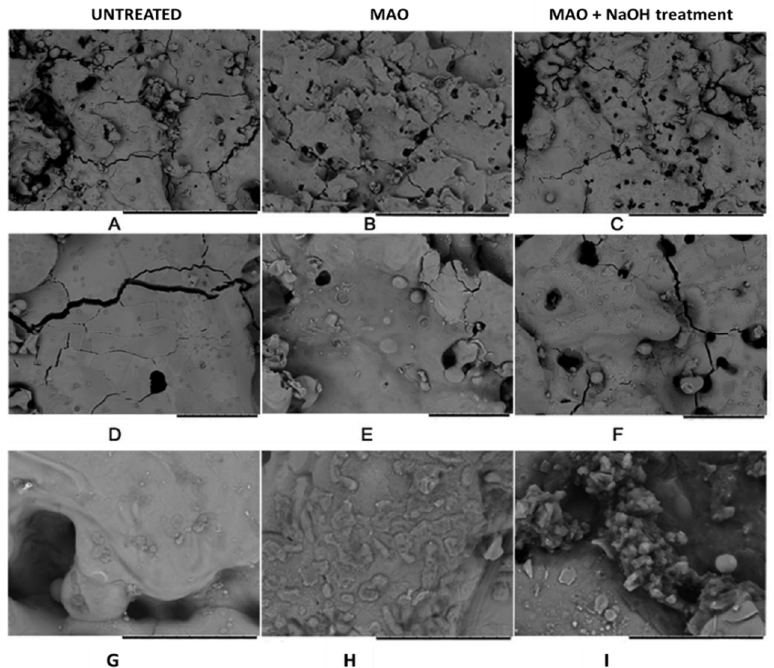
Figure 15. Surface morphologies of ( A , D ) untreated Ta surface, ( B , E ) Ta 2 O 5 prepared by MAO using the phosphate solution, and ( C , F ) with NaOH treatment.; ( G – I ) after SBF soaking. Scale bars ( A – C ) 200 μ m, ( D – F ) 30 μ m, and ( G – I ) 20 μ m. Adapted with permission from Ref. [67]. Copyright 2014 Royal Society of Chemistry.